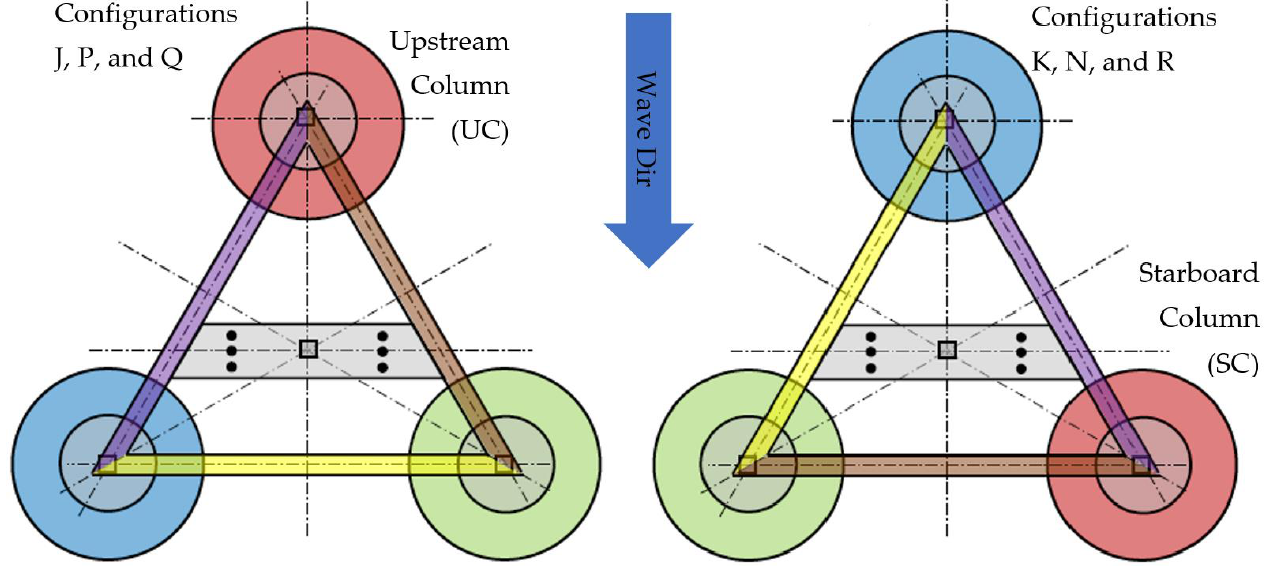
Figure 7. Three-column configurations showing the column/heave plate with pressure sensors in red. Illustration reproduced with permission from Matthew Fowler, 1/50-scale DeepCwind semi-submersible component wave testing [5]; published by the University of Maine, 2021.